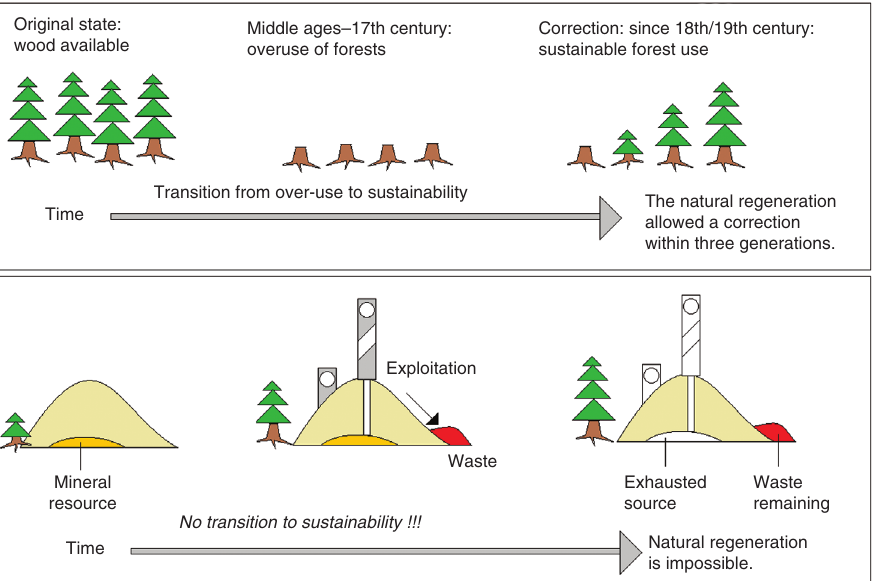
Figure 1 The origin and the future of the ideas of sustainability: overuse of resources, historical forest management, and the irreversibility of recent mineral resource